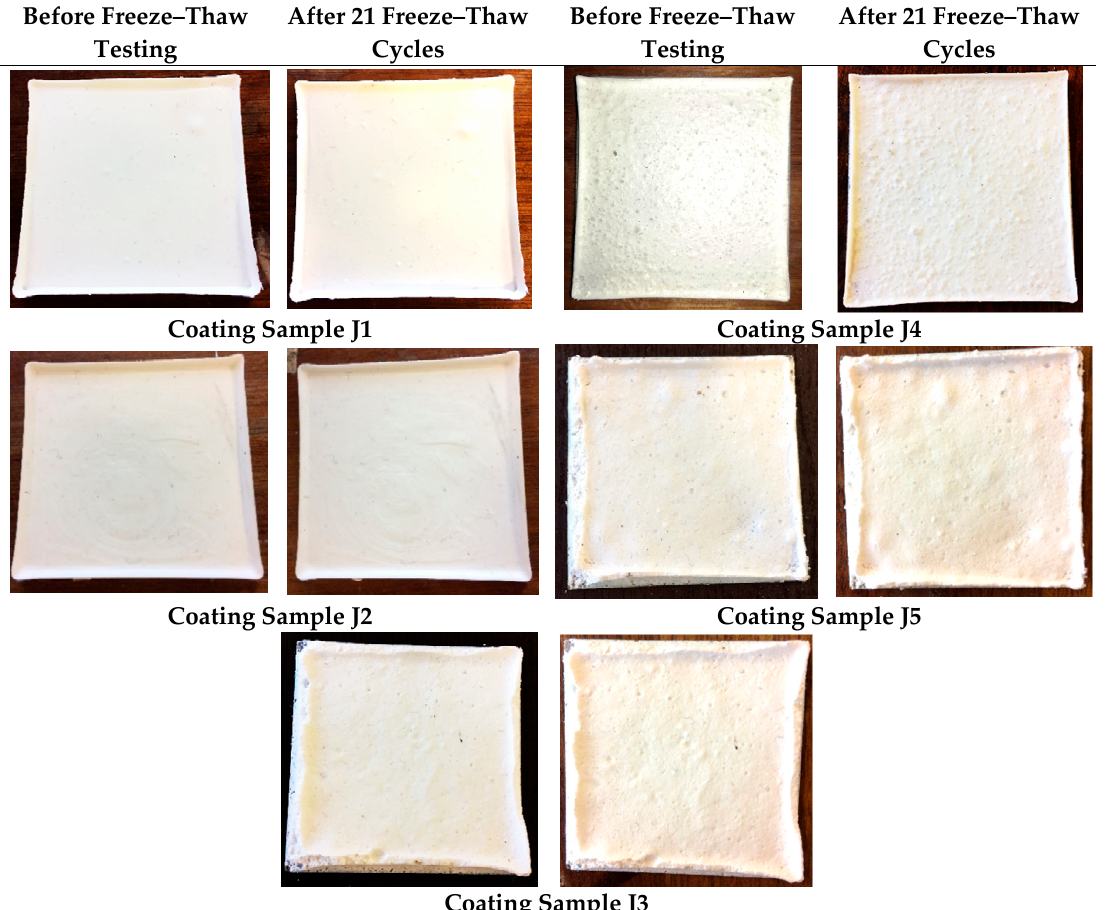
Figure 9. Before and after the freeze–thaw cycles test of the coated samples.